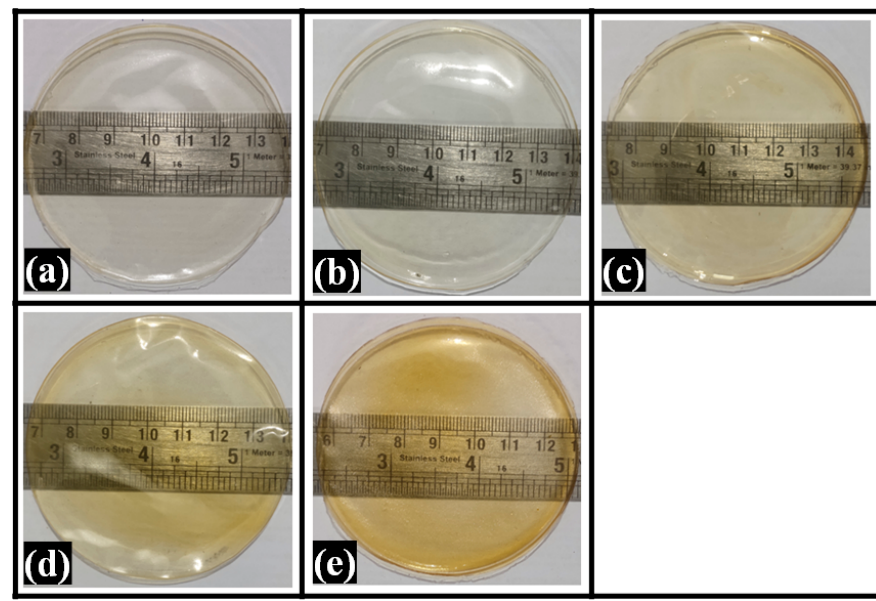
Figure 5. Digital images of the composite films ( a ) F0, ( b ) F1, ( c ) F2, ( d ) F3, and ( e ) F4.